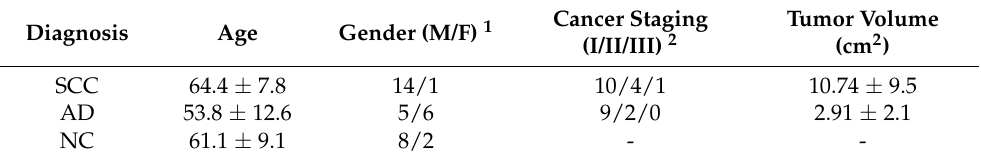
Table 1. Demographic and clinical information (mean ± standard deviation) of the studied lung cancer subjects.